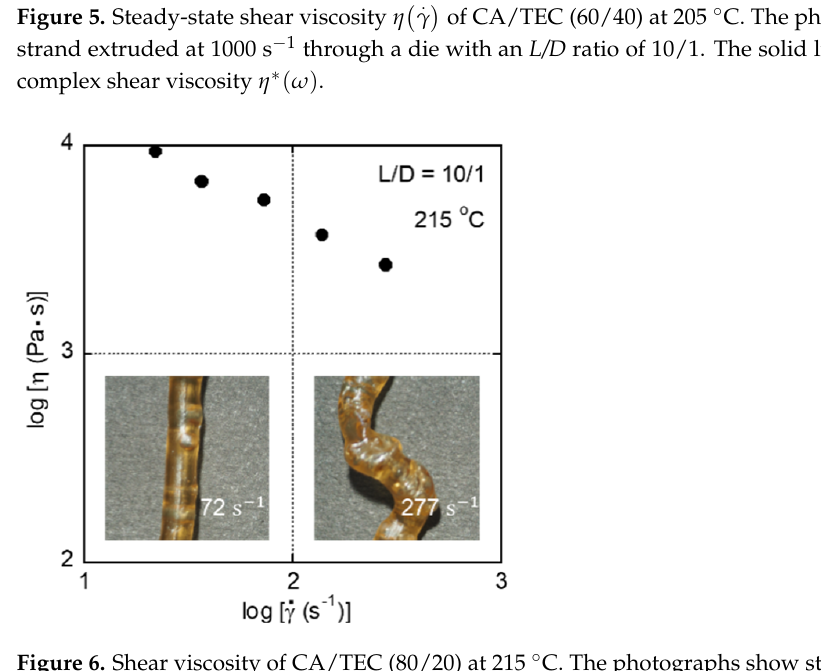
Figure 6. Shear viscosity of CA/TEC (80/20) at 215 °C. The photographs show strands extruded at 72 and 277 s − 1 through a die with an L / D ratio of 10/1.